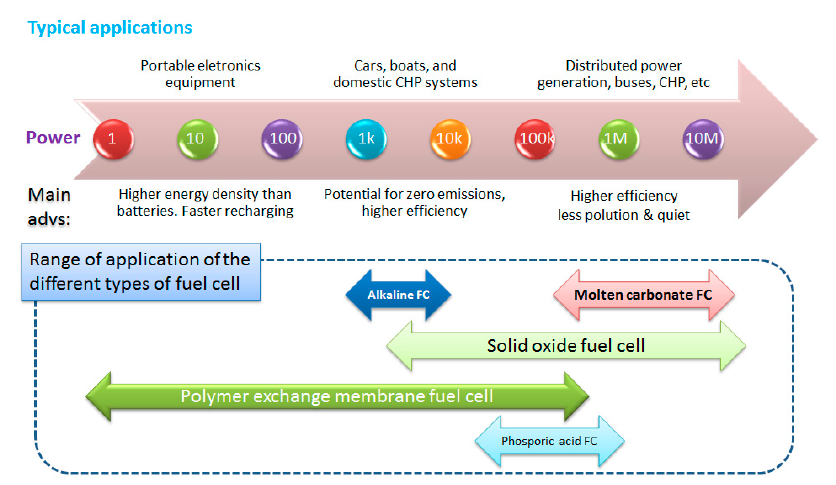
Figure 2. Summary of applications and main advantages of different types fuel cells (CHP stands for combined heat and power systems. The power unit is Watt).